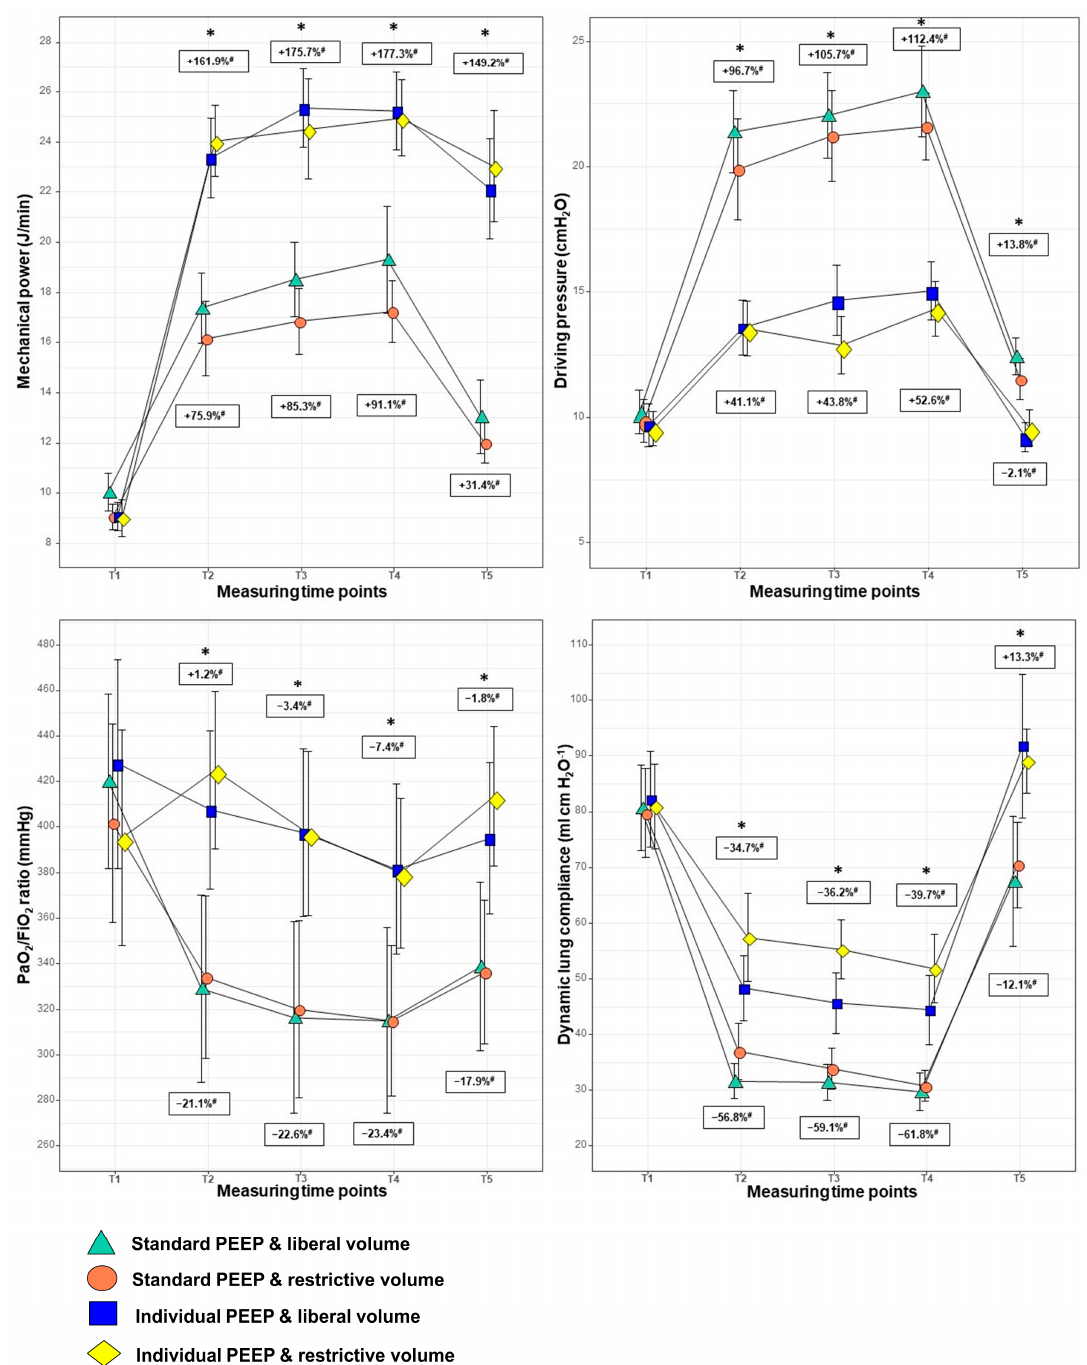
Figure 2. Differences in mechanical ventilation parameters between the study groups during robotic-assisted laparoscopic prostatectomy (n = 98) Notes: * p < 0.05; # absolute changes (%) in the added- up standard or individualised PEEP groups compared to T1; entries depict the mean (SD), and p -values compare the four treatment arms at each timepoint using an ANOVA; FiO 2 : fraction of inspired oxygen; PaO 2 : partial pressure of oxygen in arterial blood; T1: 5 min after intubation in supine position, T2: 30 min after the start of pneumoperitoneum and Trendelenburg position, T3: 60 min after the start of pneumoperitoneum and Trendelenburg position, T4: 90 min after the start of pneumoperitoneum and Trendelenburg position, T5: before extubation in supine position; mechanical power: calculated with the following formula: mechanical power = 0.098 × tidal volume × respiratory rate × (PIP − 0.5 × driving